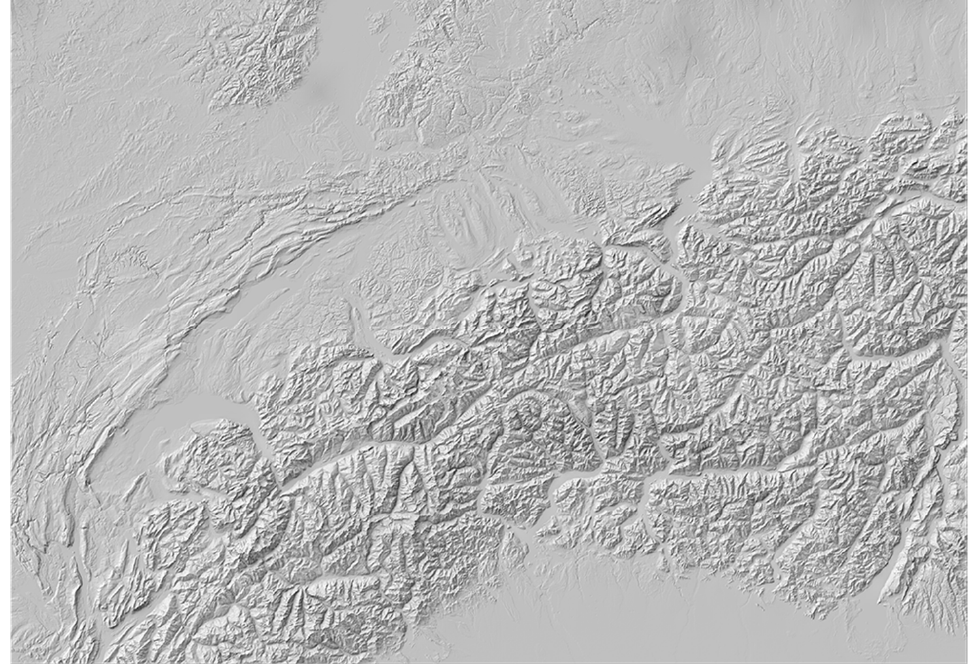
Figure 8. First-choice blended shaded reliefs.